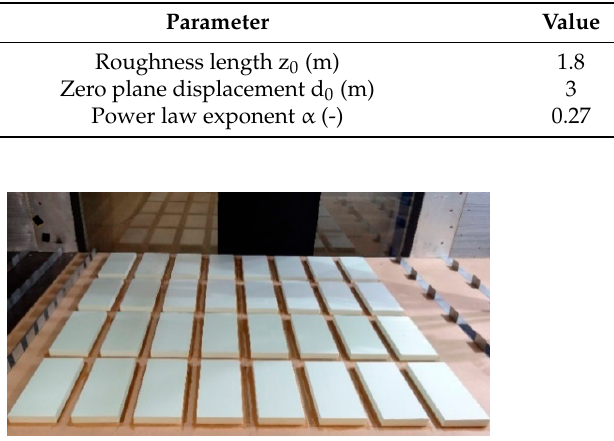
Table 1. Boundary layer characteristics—modeled values and the recommended values by the Verein Deutcher Ingenier (VDI) documentation [29].